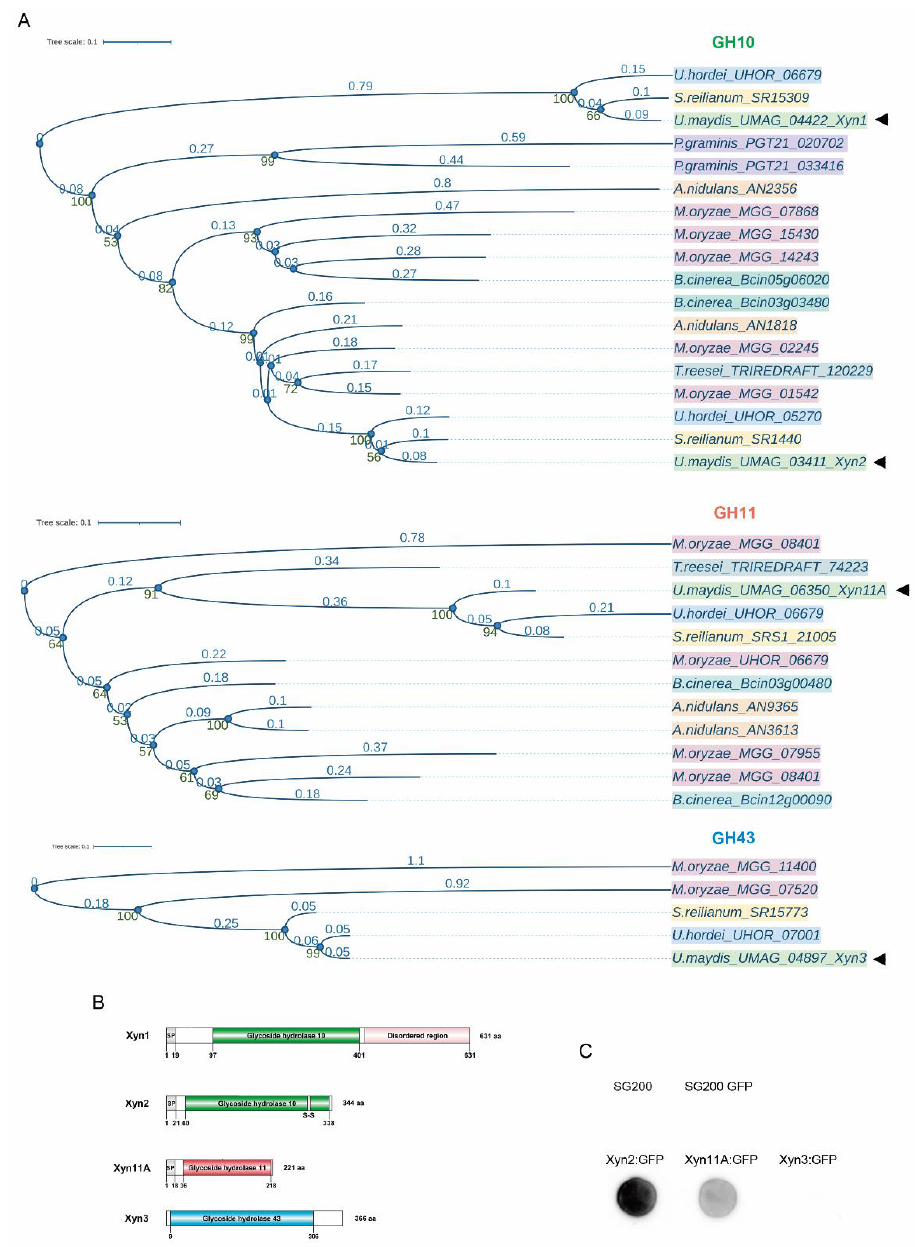
Figure 1. Ustilago maydis possesses four xylanases: two from the GH10 family, Xyn1 and Xyn2, a GH11 member, Xyn11A, and Xyn3 from the GH43 family. ( A ) Phylogenetic study of GH10, GH11, and GH43 xylanases across fungi. Each species is represented by a different color: U. maydis (light green), U. hordei (blue), S. reilianum (yellow), P. graminis (purple), M. oryzae (pink), B. cinerea (dark green), A. nidulans (orange), T. reesei (gray). Xylanases from U. maydis Xyn1, Xyn2, Xyn11A, and Xyn3 are indicated with arrowheads. Glycoside hydrolase (GH) domains are also color-coded: GH10 (green), GH11 (orange), and GH43 (blue). Bootstraps are indicated in green numbers down the nodes and distances are indicated in blue above each branch. ( B ) Schematic representation of four xylanases identified in U. maydis . GH domains of each xylanase are indicated, and signal peptide in N-terminal region is indicated by SP. ( C ) Secretion of Xyn2, Xyn11A, and Xyn3 (tagged with GFP) was assayed in a colony secretion assay. Wild-type SG200 strain was used as control for proper colony washing, and SG200 cells expressing cytoplasmic GFP under control of constitutive otef promoter served as cell lysis control (SG200-GFP).